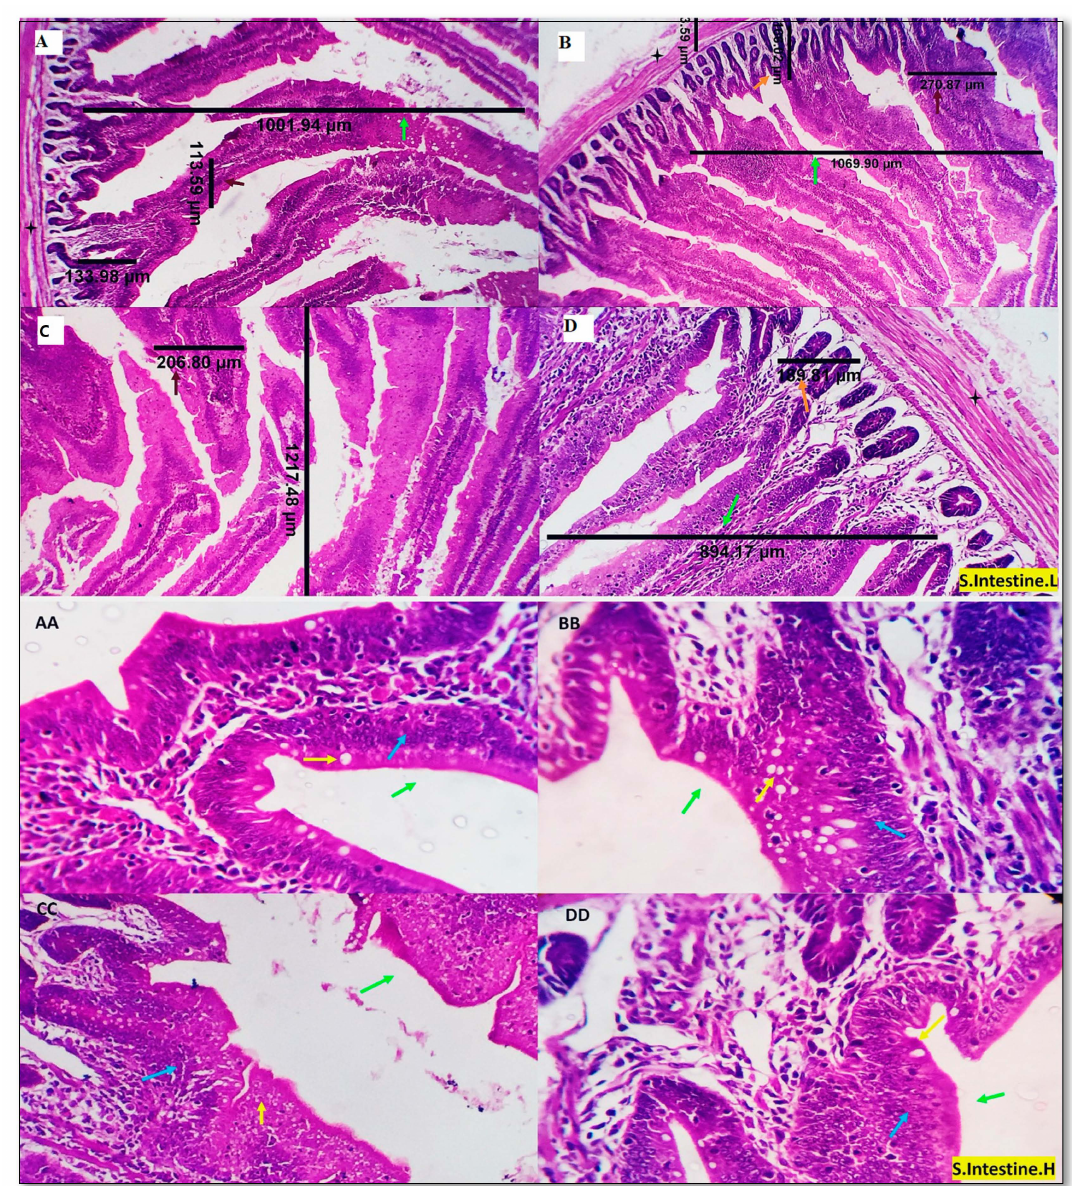
Figure 2. Photomicrographs from the small intestine (duodenum) of the experimental treatments display the different morphometric measures; VH (green arrows), VW (brown arrows), CD (orange arrows), and MCT (black stars). A moderate number of goblet cells (yellow arrows) in groups AA and BB (27 and 29 cells/HPF, respectively) and comparatively higher numbers in groups CC and DD (39 and 31 cells/HPF, respectively). Mild villous epithelial stratification with multilayered proliferate cells, central rounded nuclei, and abundant eosinophilic cytoplasm (blue arrows) can be seen in (groups BB and CC). The standard arrangement of the villous cells is observable in other groups. H&E X 100, 200. MUR0: ( A , AA ), MUR200: ( B , BB ), MUR400: ( C , CC ), MUR600: ( D , DD ) low and high power,